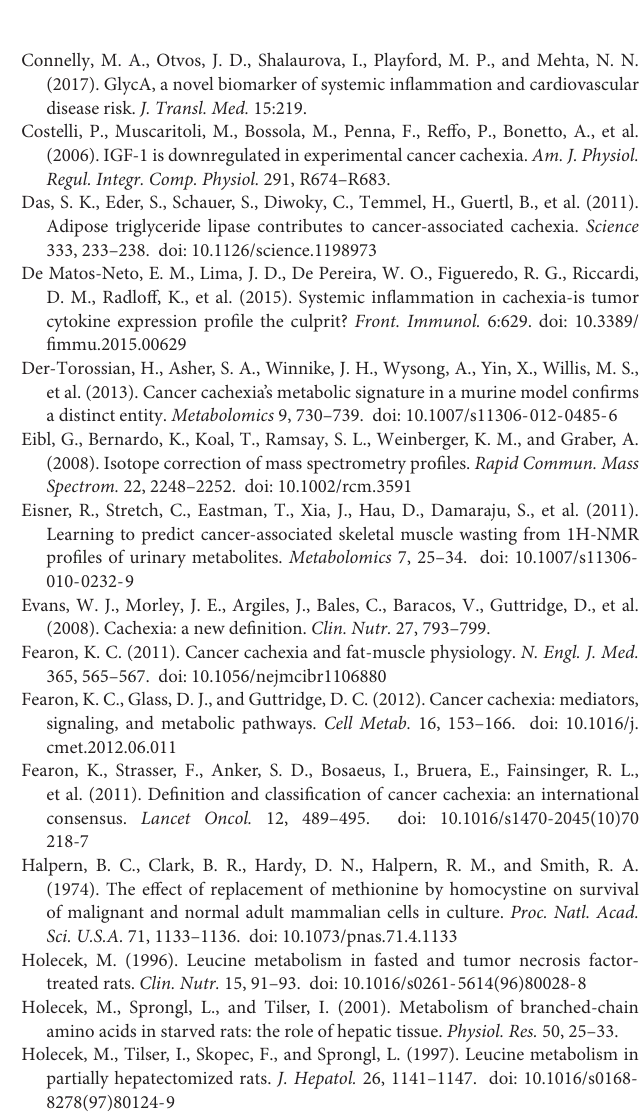
Supplementary Figure 1 | Boxplots for body weight, tumor volume, and muscle weights in the tumor bearing mice at days 10, 12, and 14. The body weight of the mice at day 12 are significantly lower than at day 10 but not statistically different from day 14. The tumor volumes as well as the muscle weights (gastrocnemius, tibialis, and quadriceps) are not significantly different in these last three timepoints suggesting a similar degree of cachexia. Supplementary Table 1 | p -Values for the differences between relative body weight and skeletal muscles in control versus cachectic mice. Red indicates a p -values < 0.05. No significant differences were observed prior to day 7. Supplementary Table 2 | Estimates and standard errors of the metabolites at each day from the quadratic model. Control_ and C26_Estimate, estimated means for the metabolite concentrations; Control_ and C26_StError, estimated standard errors for the metabolite concentrations; Diff_Estimate, difference of the estimated means between Control and C26 groups at each timepoint; Diff_StError, standard errors of the difference between the Control and C26 groups at each timepoint; t -stat, T -statistic from pairwise comparison of means of Control and C26 groups at each timepoint; p -values, p -values from pairwise comparison of means of Control and C26 groups at each